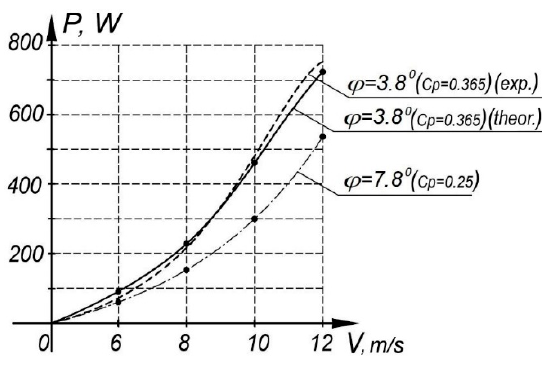
Figure 12. Power curves of the wind turbine.